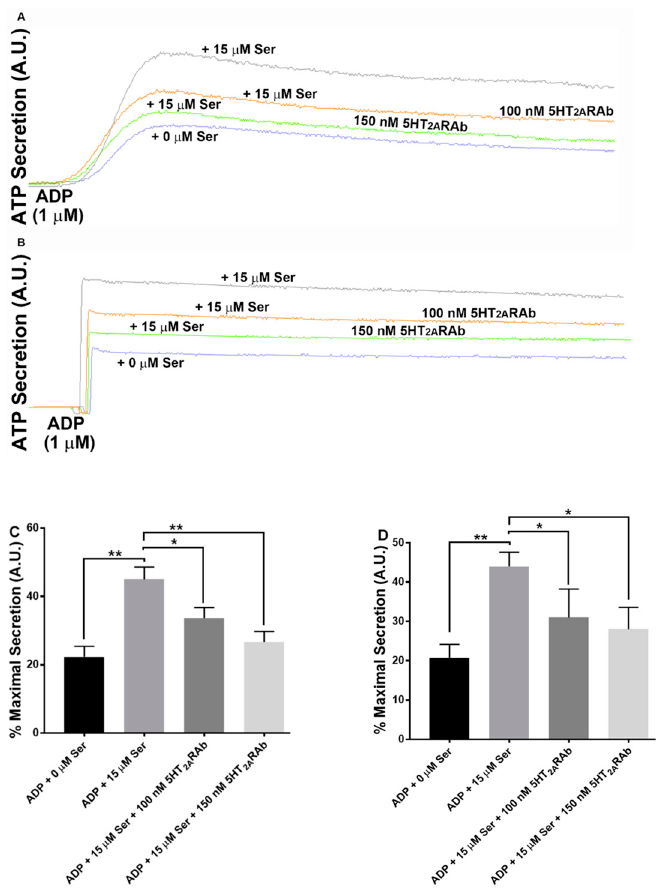
Figure 4. The 5HT 2A RAb inhibits serotonin-enhanced ADP-induced dense granule secretion in hu- man (in vitro) and mouse platelets (ex vivo). ( A ) Human PRP was incubated with luciferase luciferin (12.5 μ L), in the presence and absence of increasing doses of 5HT 2A RAb (100–150 nM) for 5 min before being activated with a submaximal concentration of ADP (1 μ M) with or without serotonin (15 μ M); ( C ) shows quantification of the maximum secretion data. ( B ) Mouse PRP obtained from vehicle- or 5HT 2A RAb-injected mice (100–150 nM) once daily for 5 days, preincubated with lucifer- ase luciferin (12.5 μ L), and stimulated with submaximal concentration of ADP (1 μ M) in the pres- ence or absence of serotonin (15 μ M); ( D ) shows quantification of the maximum secretion data. ATP release (dense granules) was detected as luminescence and measured by a lumi aggregometer. (* p < 0.05; ** p < 0.01. Each experiment was repeated 3 times, with blood pooled from 6–8 mice each time and data were analyzed using one-way